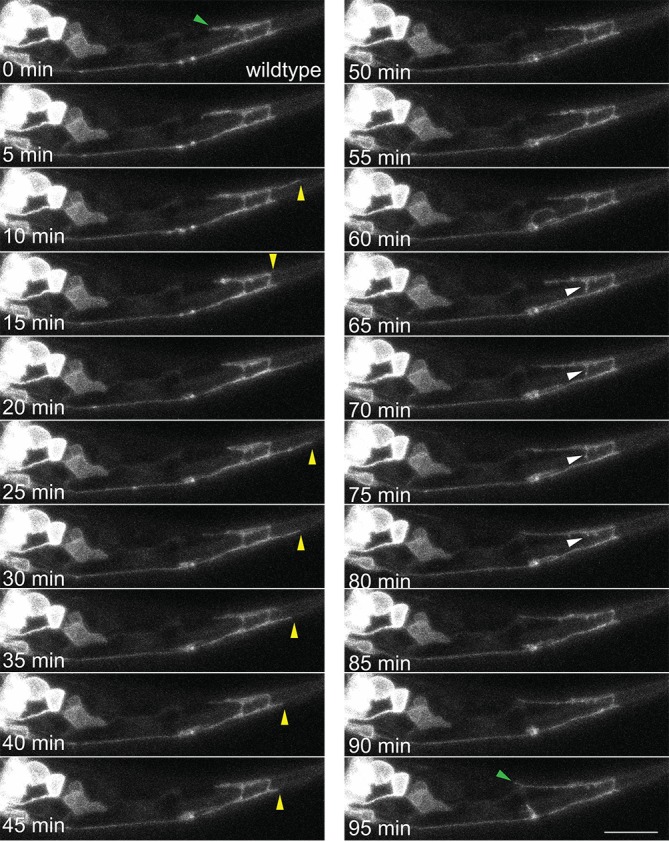
Time-lapse imaging of PDB neurite pruning.PDB neurite is labeled with ZF1-GFPnovo2::CAAX of the mizIs9 transgene. Images were taken every 5 min. Green arrowheads denote the end of anterior neurite in the first and last frame, and yellow arrowheadss denote the end of posterior neurites during two pruning events. White arrowheads indicate transient neurites from the anterior neurites. We did not conduct detailed analyses on the pruning of these neurites since their position and the timing are less stereotyped than the posterior neurites. Scale bars: 10 μm.